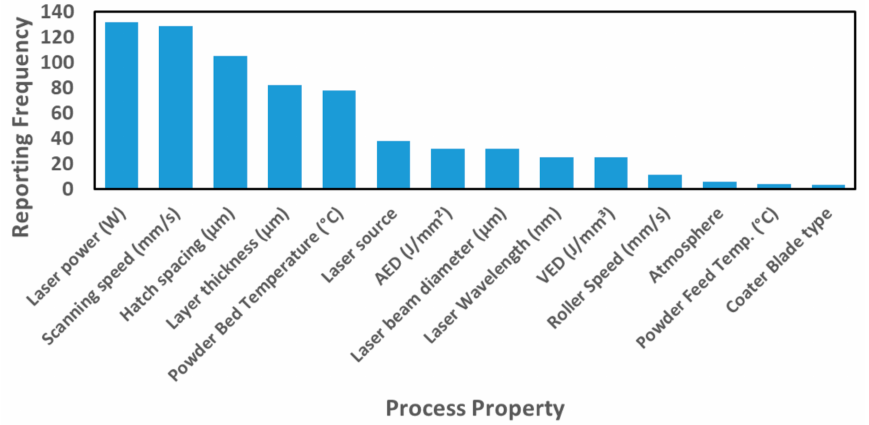
Figure 9. Reported process properties for L-PBF of polymer powder feedstocks and their reporting frequencies in the articles